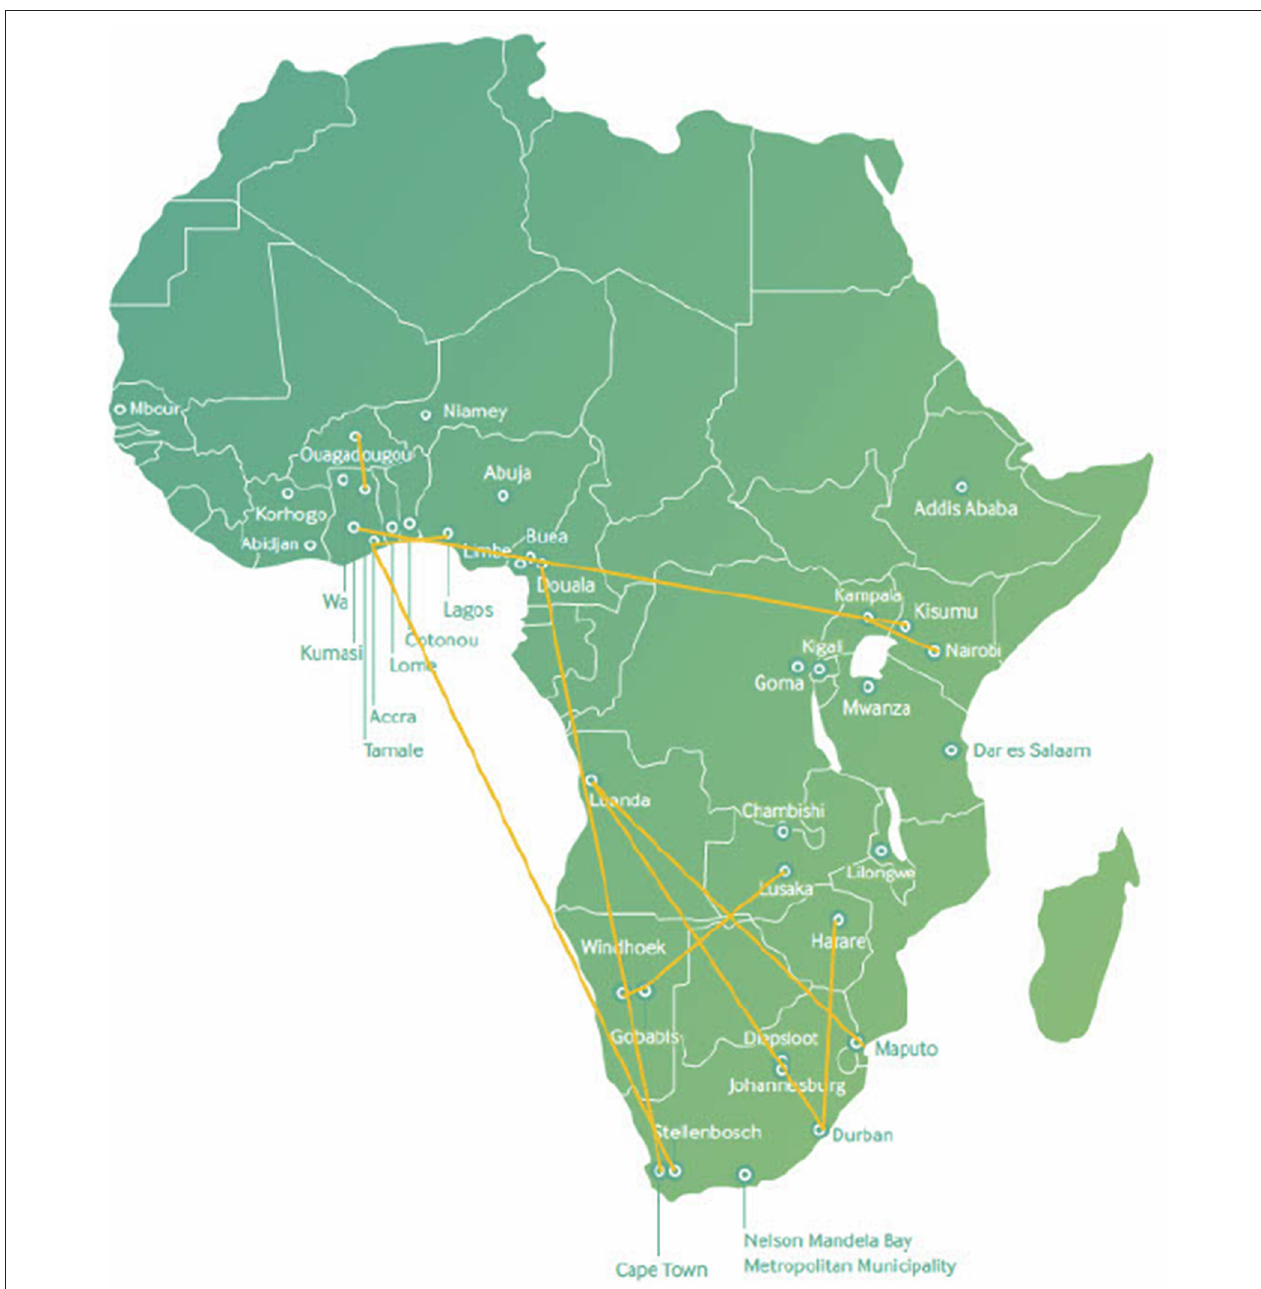
FIGURE 1 | Cohort 2—Geographical